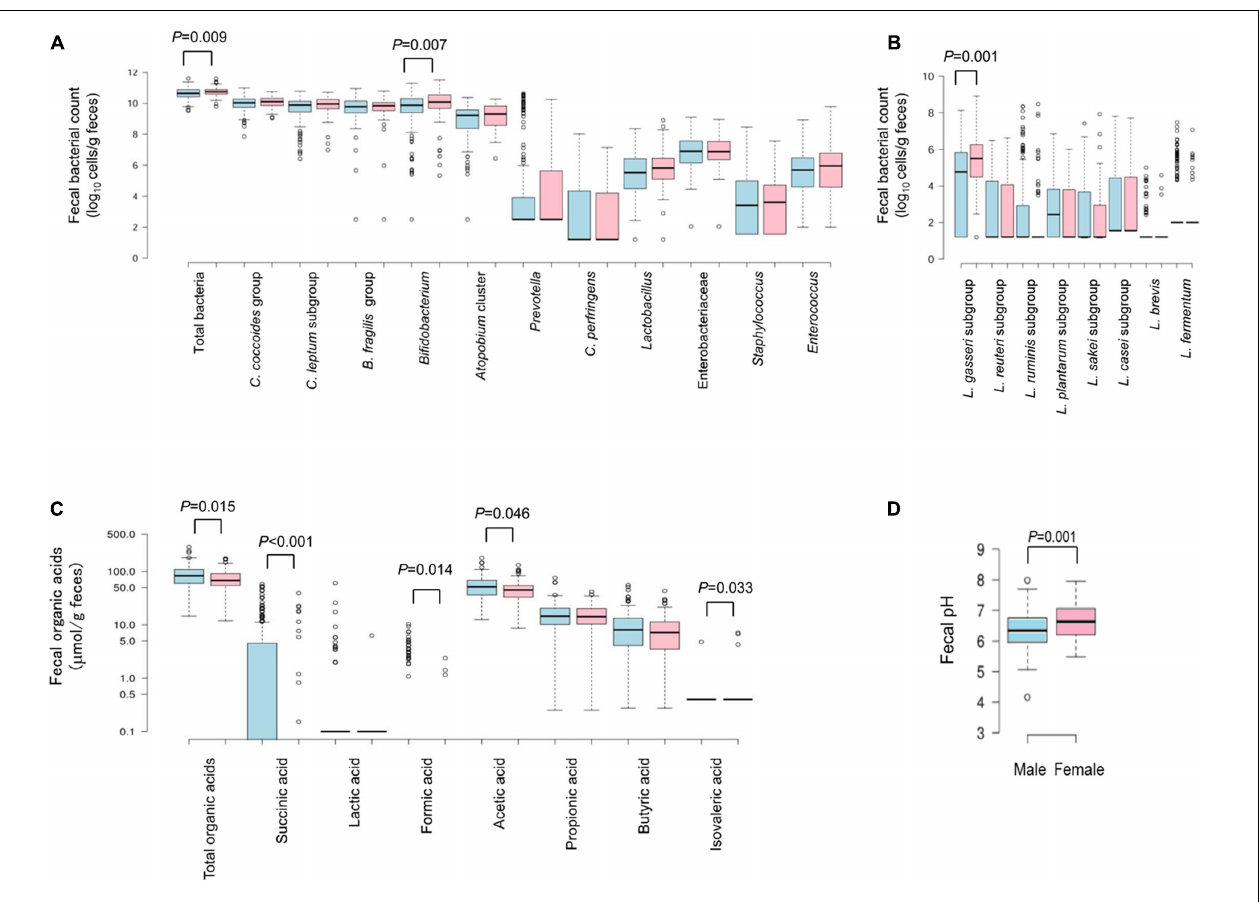
FIGURE 1 | Fecal count of major intestinal bacterial groups (A) and Lactobacillus subgroups/species (B) , fecal concentration of organic acids (C) , and fecal pH (D) in healthy Japanese college students profiled by gender. Blue box: males ( n = 212); pink box: females ( n = 81). Center lines show the medians; box limits indicate the 25th and 75th percentiles as determined by R software; whiskers extend 1.5 times of the interquartile range from 25th and 75th percentiles; outliers are represented by dots. Only P < 0.05 is indicated